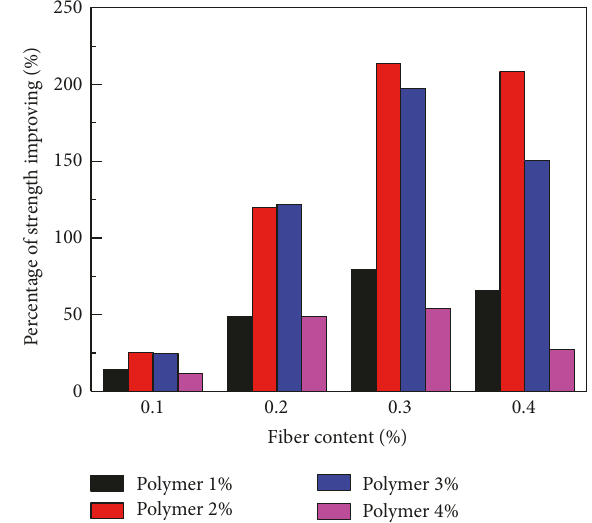
Figure 6: Unconfined compressive strength (UCS) of samples. Figure 7: Percentage of strength improving of